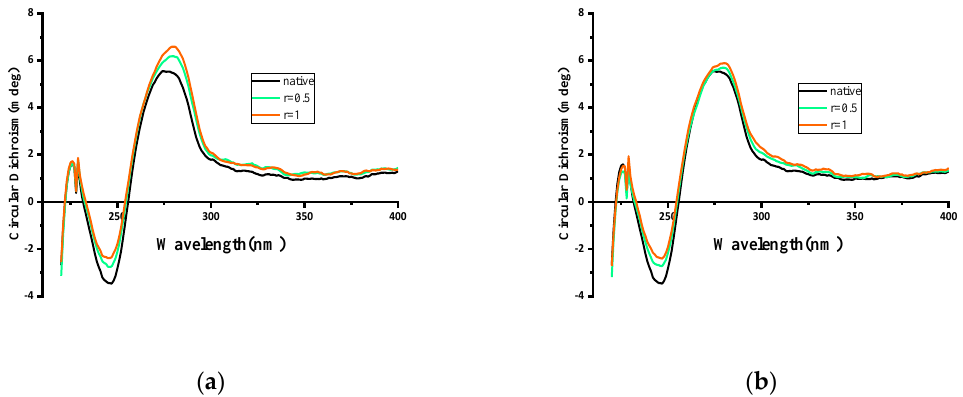
Figure 10. CD spectra of compounds ( a ) 1 and ( b ) 3 to CT-DNA at different concentration ratios.